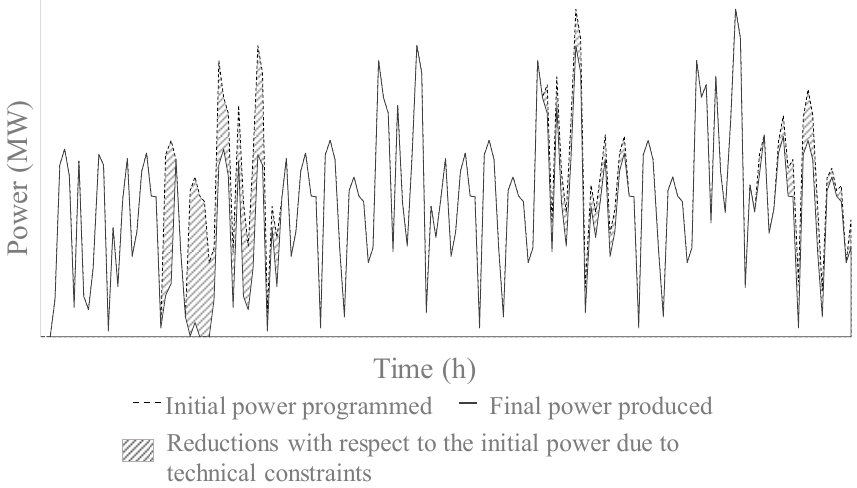
Figure 5. Initial power programmed for a wind farm and actual power produced.